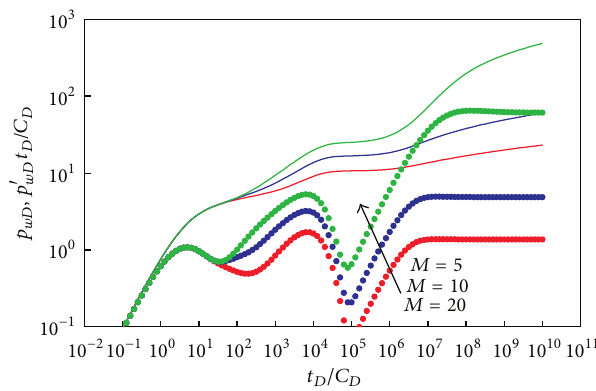
Figure 9: Effect of total branch level ( 𝑀 ) on type curves ( 𝛼 = 1 , = 10 m, 𝑑 = 0.05 m, 𝐷 𝛽 = 0.65 , 𝜃 = 1 , 𝑁 = 4 , 𝑀 = 10 , 𝑙 0 0 = 4 , 𝑟 = 0.1 m, 𝑆 = −1 , 𝐶 = 0.0001 , ℎ = 10 m, 𝐶 𝑇 𝑚 𝑤 𝐷𝑒 = 1 × 10 −4 MPa −1 ). 2.2 × 10 −5 MPa −1 , and 𝐶 𝑓𝑡